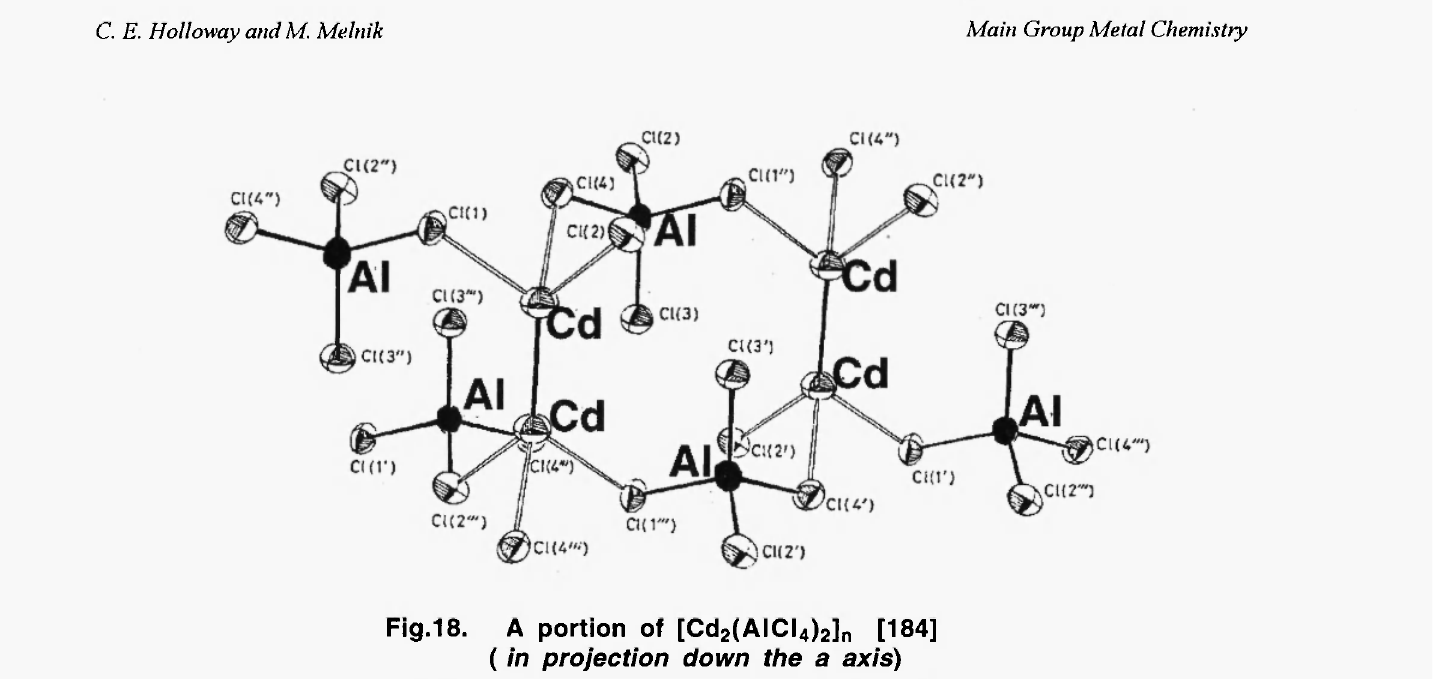
Fig.18. A portion of [Cd 2 (AICI 4 ) 2 ]n [184] (in projection down the a